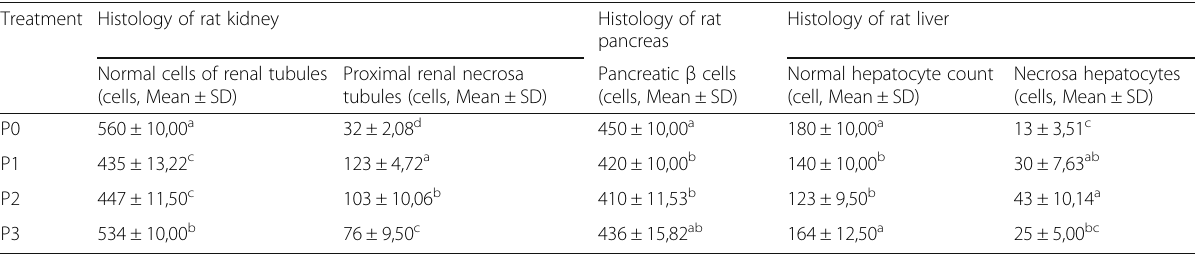
P0=the negative control, P1=the positive control, P2=the ethyl acetate extract of the Malaka flesh given a concentration of 100mg/kg body weight, P3=the ethyl acetate extract of the Malaka flesh given a concentration of 200mg/kg body weight. Different letters showed significant differences among the group ( p